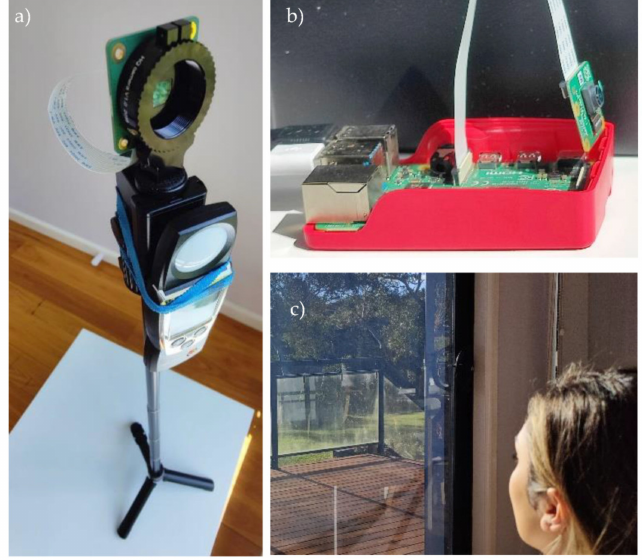
Figure 9. DGP field measurement: ( a ) HDR camera; ( b ) False-color imaging; and ( c ) Human subjects’ assessment.